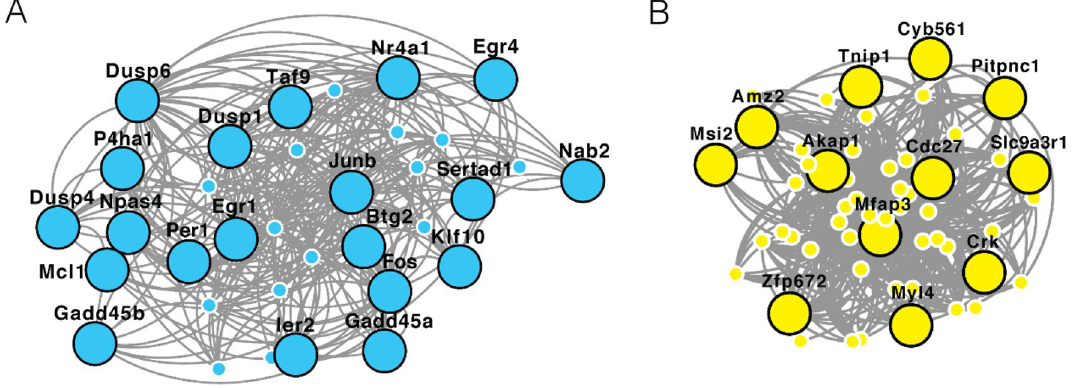
Figure 3. Coexpression networks for skyblue ( A ) and lightyellow ( B ) were calculated using weighted gene coexpression network analysis. The large, labeled nodes are the module members that are modulated in